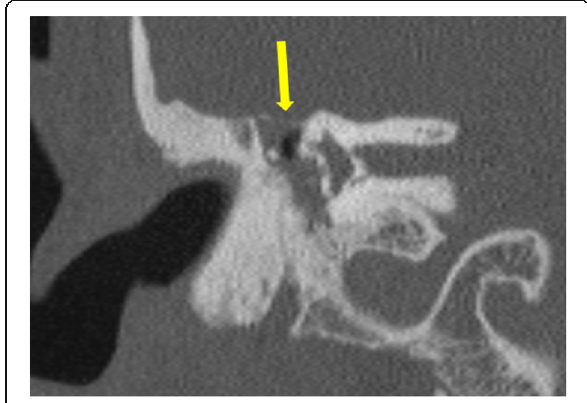
Fig. 13 Coronal CT image showing erosion with focal defects in tegmen tympani